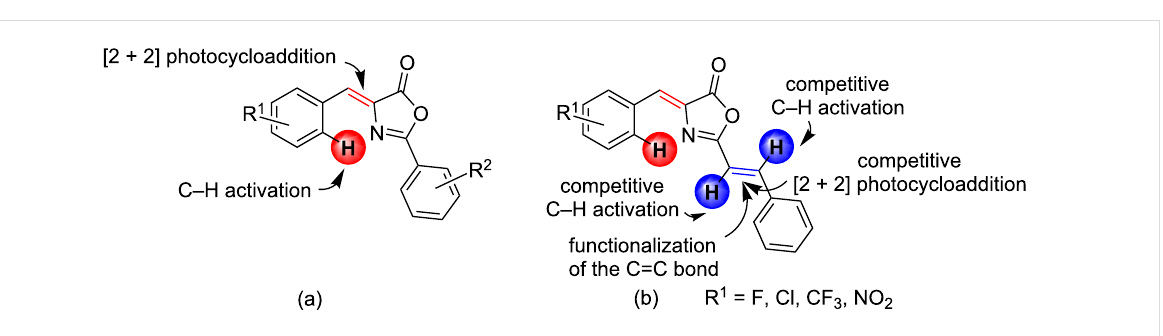
Figure 2: (a) ( Z )-4-Arylidene-2-aryl-5(4 H )-oxazolones used for the synthesis of 1,3-diaminotruxillic derivatives by direct [2 + 2] photocycloaddition of the exocyclic C=C bond or by incoporation of Pd to the oxazolone skeleton through C–H activation followed by [2 + 2] photocycloaddition; (b) ( Z )-4- arylidene-2(( E )-styryl)-5(4 H )-oxazolones studied in this work with all synthetic possibilities